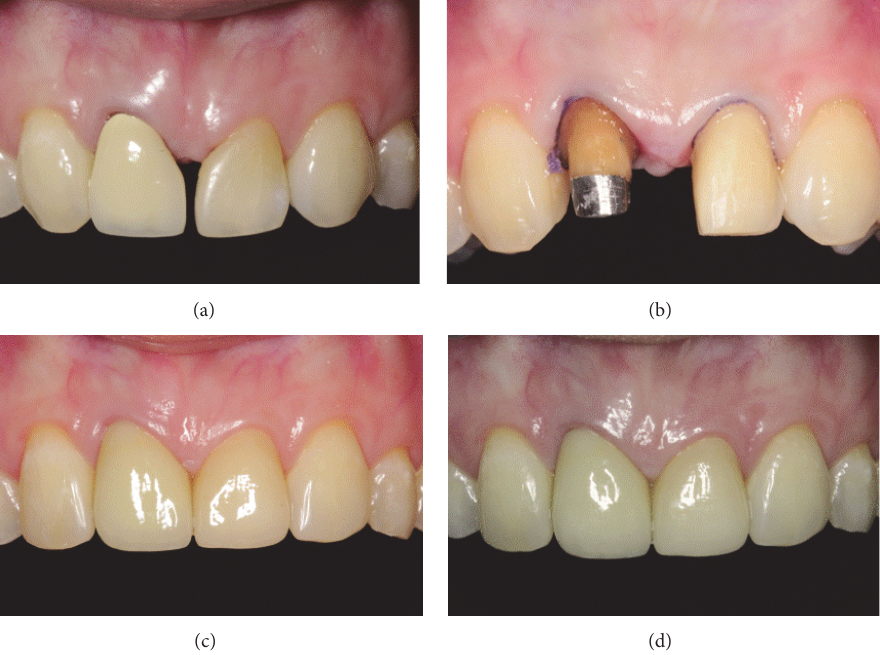
Figure 4: Front views of intraoral photographs. (a) Before treatment. (b) Teeth preparation. (c) At 2 weeks after completing treatment. (d) At 18 months after completing